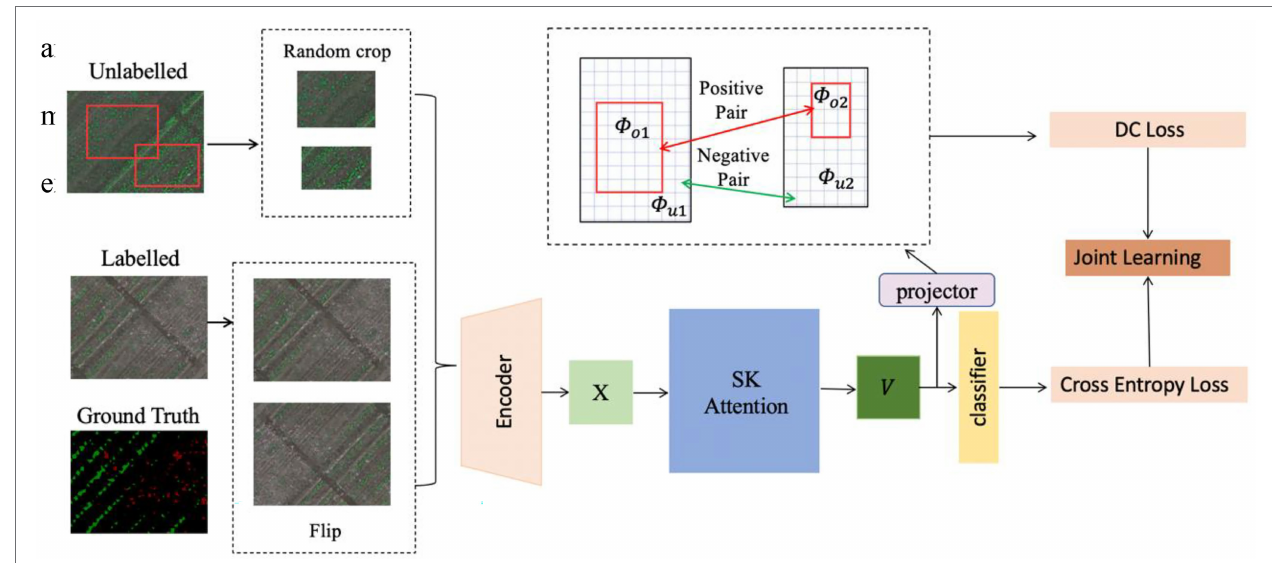
FIGURE 1 | Overall framework of the proposed method, SemiWeedNet.